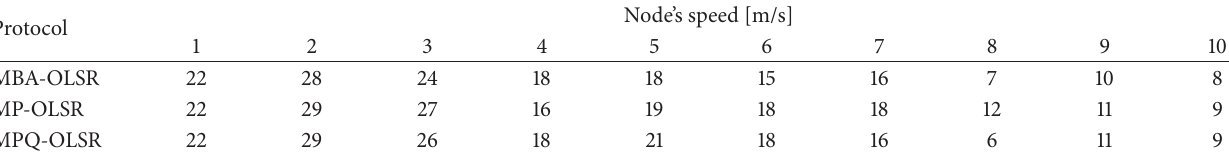
Table 3: Number of dead nodes for varying speed.